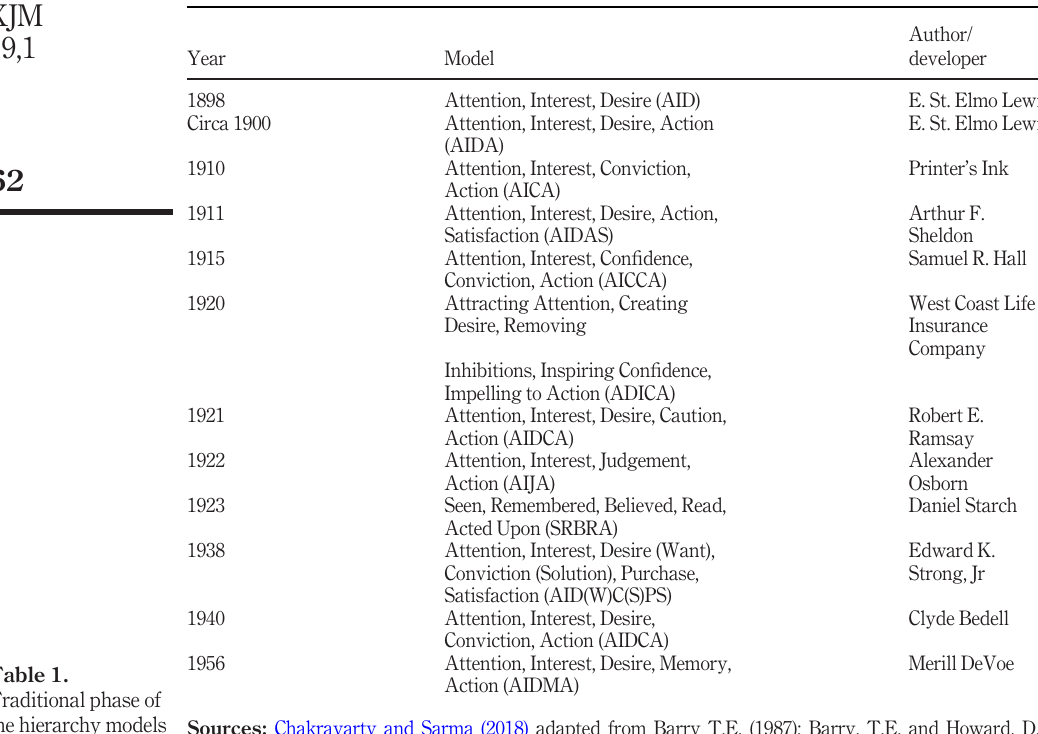
Table 1. Traditional phase of the hierarchy models of